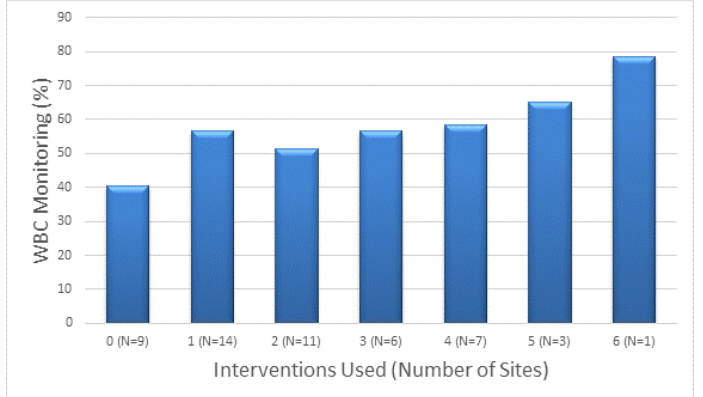
Figure 1. The rate of WBC monitoring is shown for sites using increasing number of interventions. The monitoring rate increased with greater use of interventions ( p = 0.05 for trend). When WBC rate was considered continuous the trend was more significant ( p = 0.005), 3.8% increase for each additional intervention (95% CI 1.2–6.4).